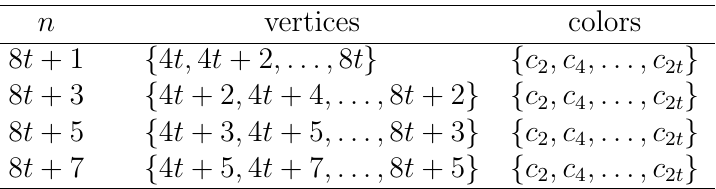
Table 4: Unmatched vertices and